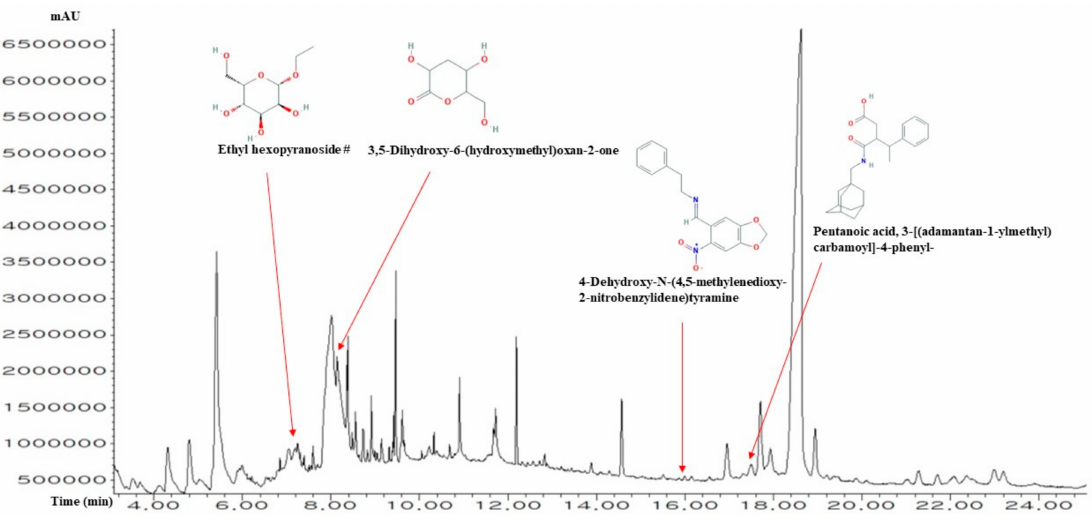
Figure 2. A typical GC-MS peak of ICLs.